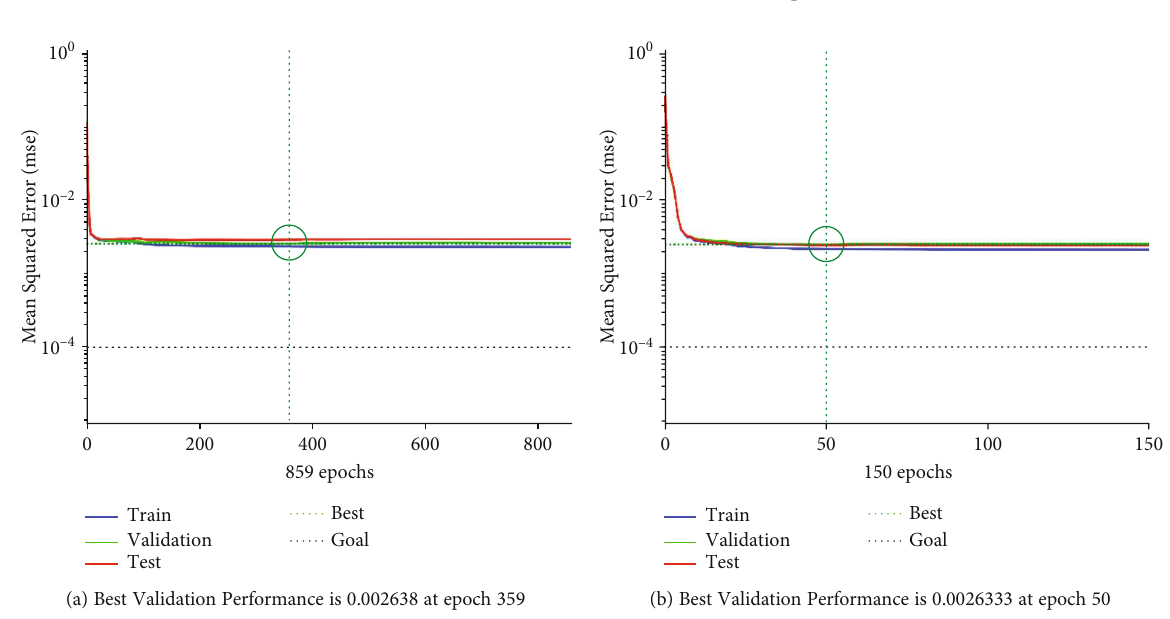
Figure 7: Flowchart of ML-based HAGSR estimation processes.